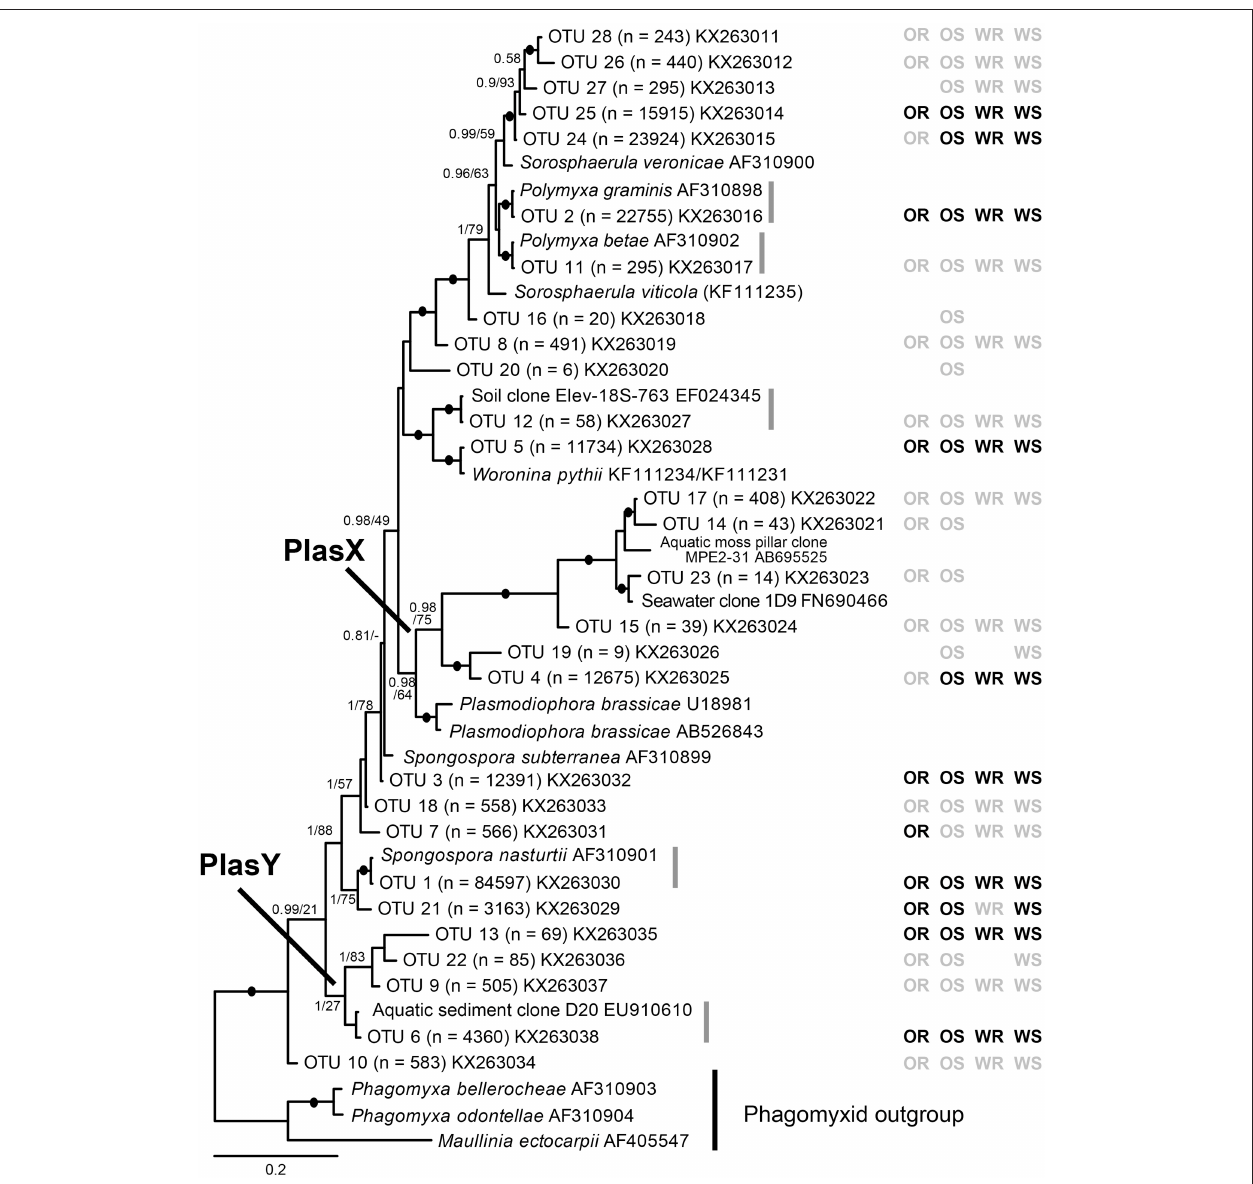
FIGURE 1 | Bayesian analysis of 18S rDNA sequences of 28 plasmodiophorid OTUs generated in this study with all available reference sequences covering the same (V7-V9) 18S region. The matrix to the right of the tree indicates whether the OTUs were detected in oilseed rape rhizosphere/bulk soil (OR/OS) and wheat rhizosphere/bulk soil (WR/WS). Black symbol, core taxa; gray, satellite; absent symbols, not detected. The tree contains 44 taxa; 1625 positions included in the analysis (of which the OTU phylotypes account for c. 450 bp). Support values are shown for Bayesian posterior probabilities > 0.75 and Maximum Likelihood (RAxML) bootstrap value > 75%, or lower at nodes of particular relevance to this study are mapped onto the Bayesian tree. Black filled circles indicate support of > 95% bootstrap and 0.95 posterior probability. Scale bar represents evolutionary distance in changes per